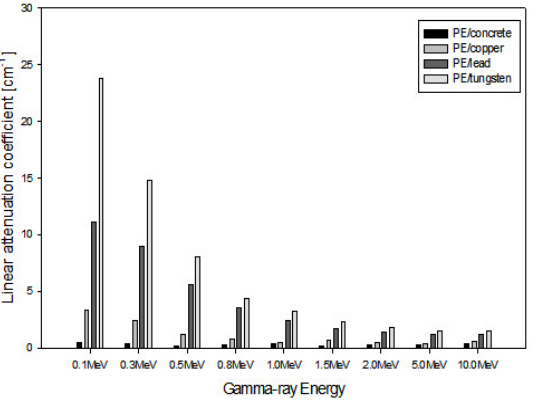
Figure 11. Linear attenuation coefficient of fibrous composite; fiber diameter 0.0798 cm.